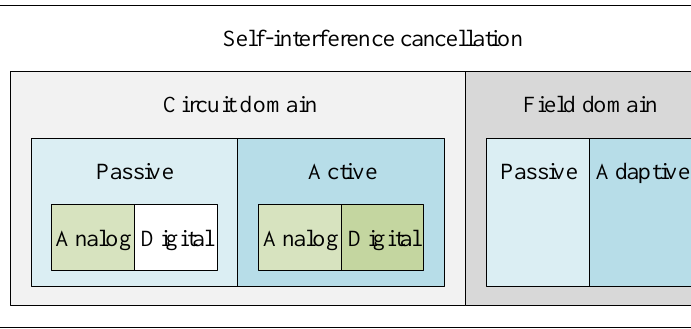
Figure 4. Classification of the SIC techniques.